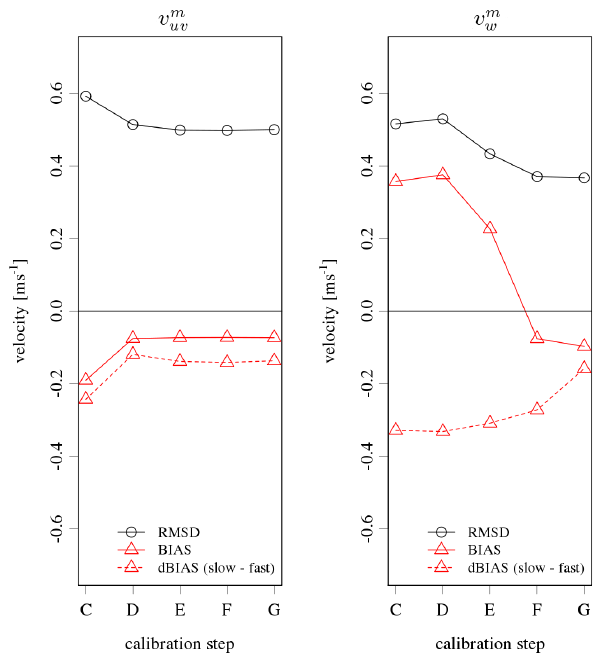
Fig. 13. Influence of the calibration steps C–G on root mean square error (RMSE) and bias (BIAS) between weight-shift microlight aircraft and all simultaneous ground based measurements of the horizontal ( v m uv ) and the vertical ( v m w ) wind components. dBIAS indicates the difference in BIAS between measurements at 27 and 24 m s − 1 true airspeed.